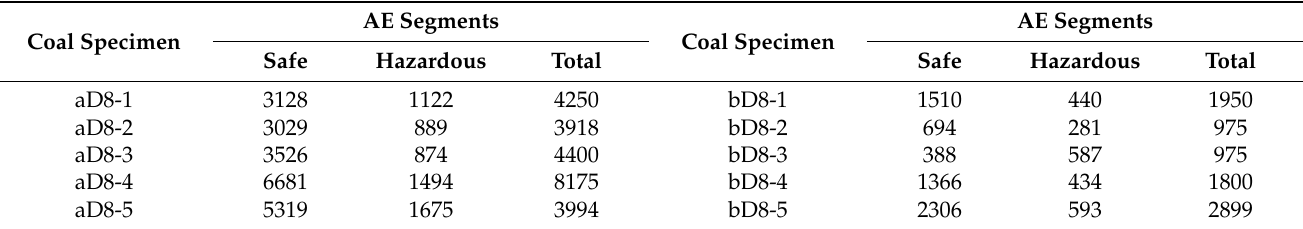
Table 3. Table 3. Statistics of the safe and hazardous samples in AE segments of each coal